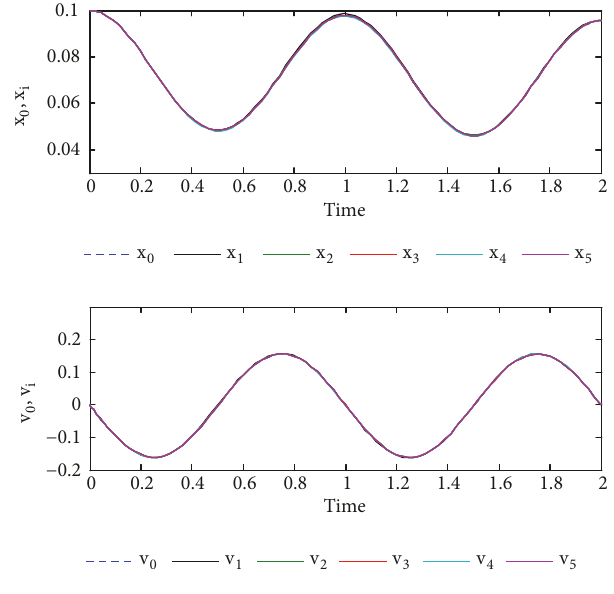
Figure 2: Tracking results of position and velocity.